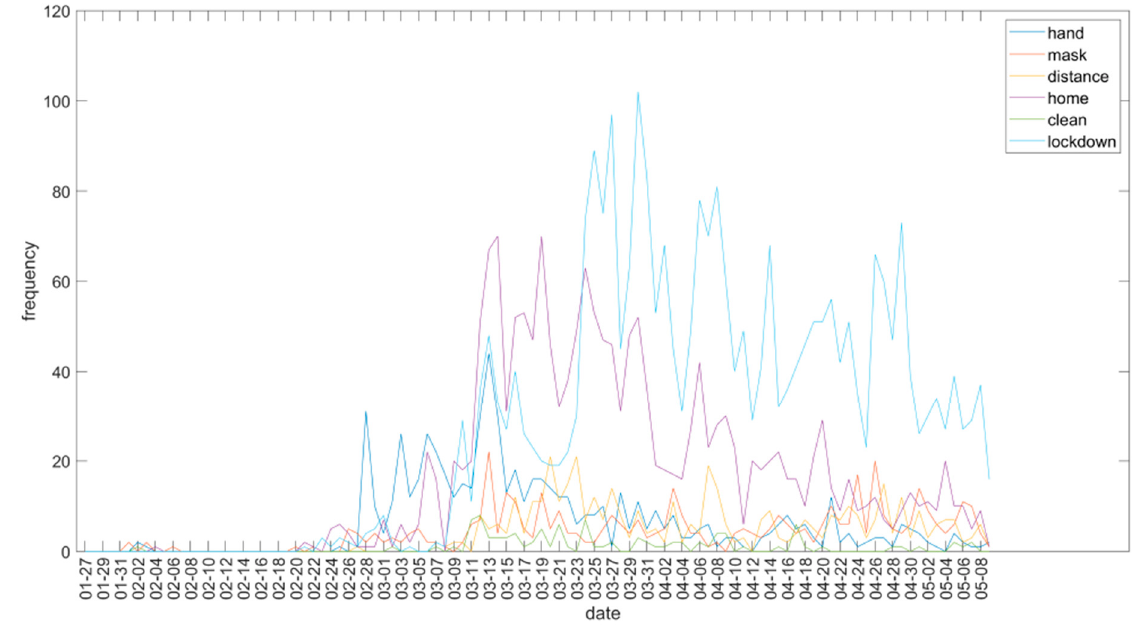
Figure 4. Dynamics of the five terms that are most related to coronavirus prevention measures during the study period .